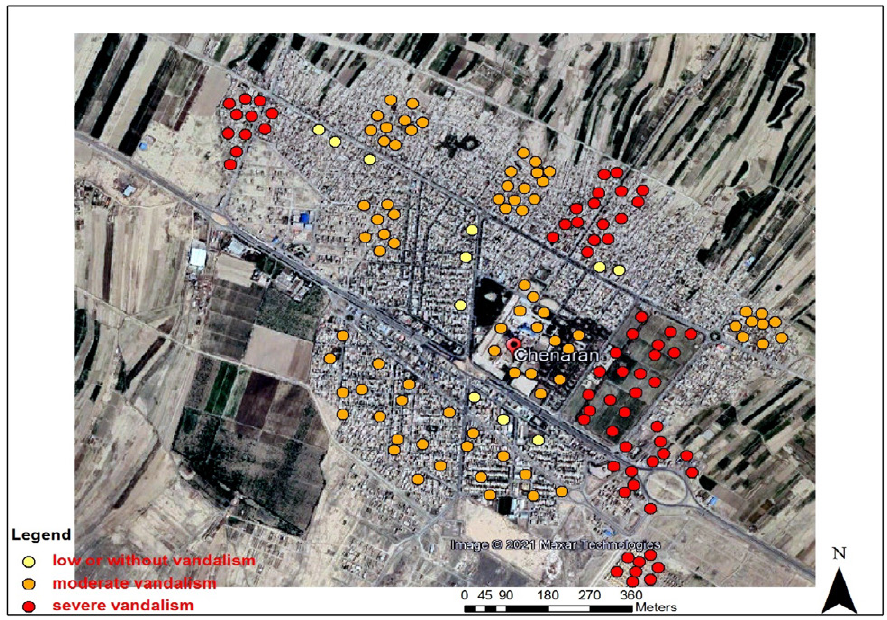
Fig.3: Distribution of vandalism in urban areas (neighborhoods) of Chenaran City Fig. 3: Distribution of vandalism in urban areas (neighborhoods) of Chenaran City (Chenaran Municipality, 2020) (Chenaran Municipality, 2020)